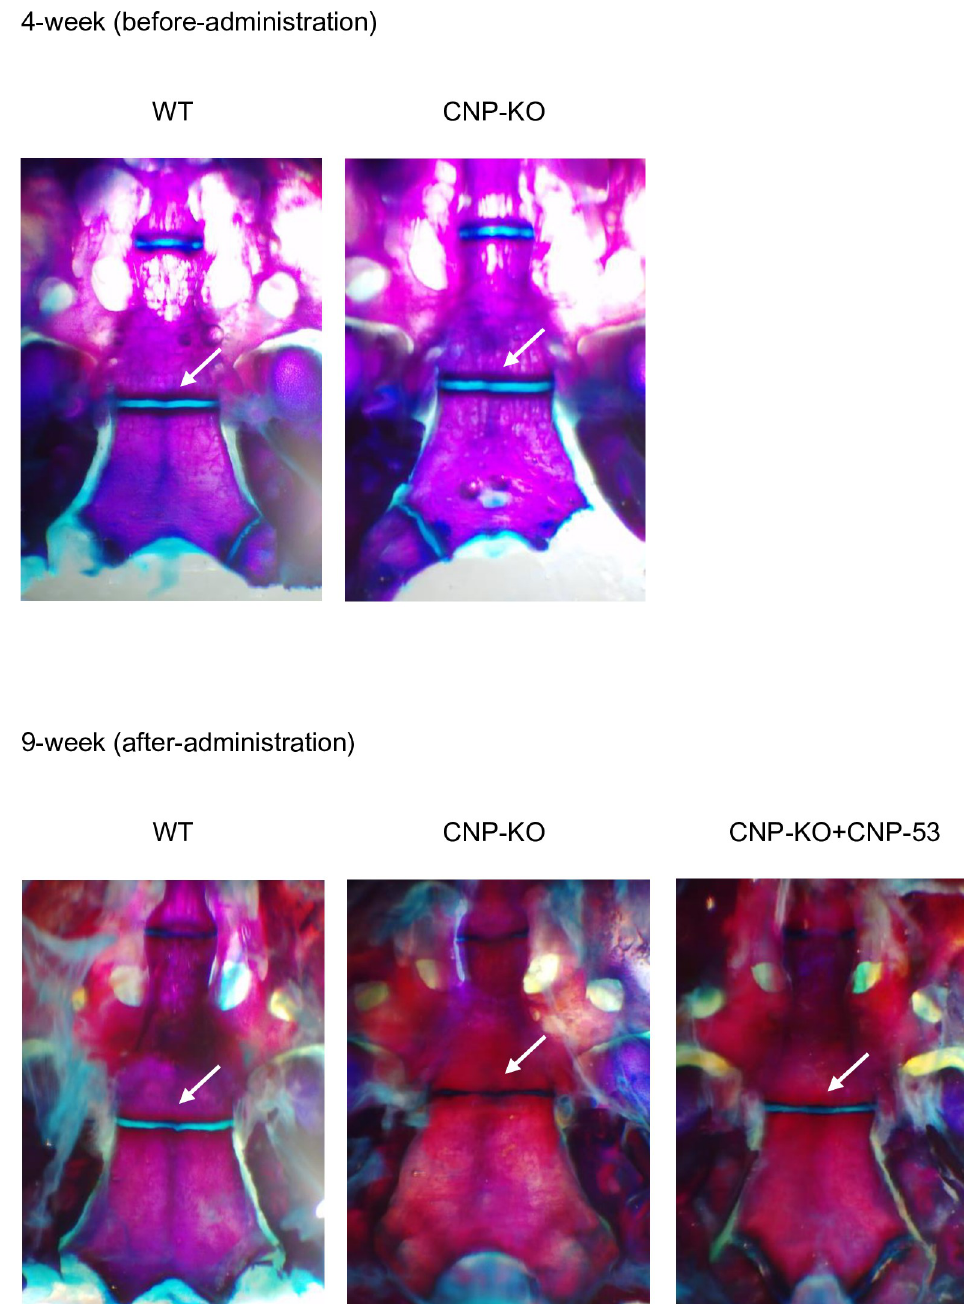
Fig 5. Appearance of the synchondrosis at the cranial base after staining with alcian blue and alizarin red. Arrow indicates the SOS. therapeutic potential of CNP for the treatment of foramen magnum stenosis and midfacial hypoplasia in achondroplasia. The developmental mechanisms of midfacial hypoplasia and foramen magnum stenosis in achondroplasia are related to FGFR3 and mitogen-activated protein kinase (MAPK) signaling in chondrocytes, which regulates synchondrosis closure, osteoblast differentiation, and bone formation [13]. FGFR3 is a key negative regulator of